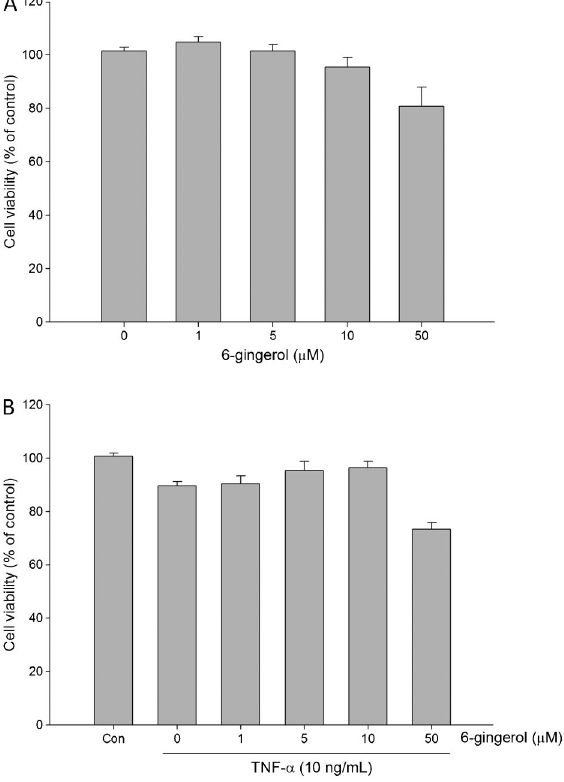
Figure 2. 6-Gingerol stimulated alkaline phosphatase (ALP) activity in MG-63 cells treated without ( A ) or with ( B ) stimulation of tumor necrosis factor (TNF)- a . Cells were treated with serial concentra- tions of 6-gingerol (0-50 m M) for 48 h. Data are reported as means±SE for 3 independent experiments. # P , 0.05 compared to 0 m M; *P , 0.05 compared to control (Con) (Student’s t